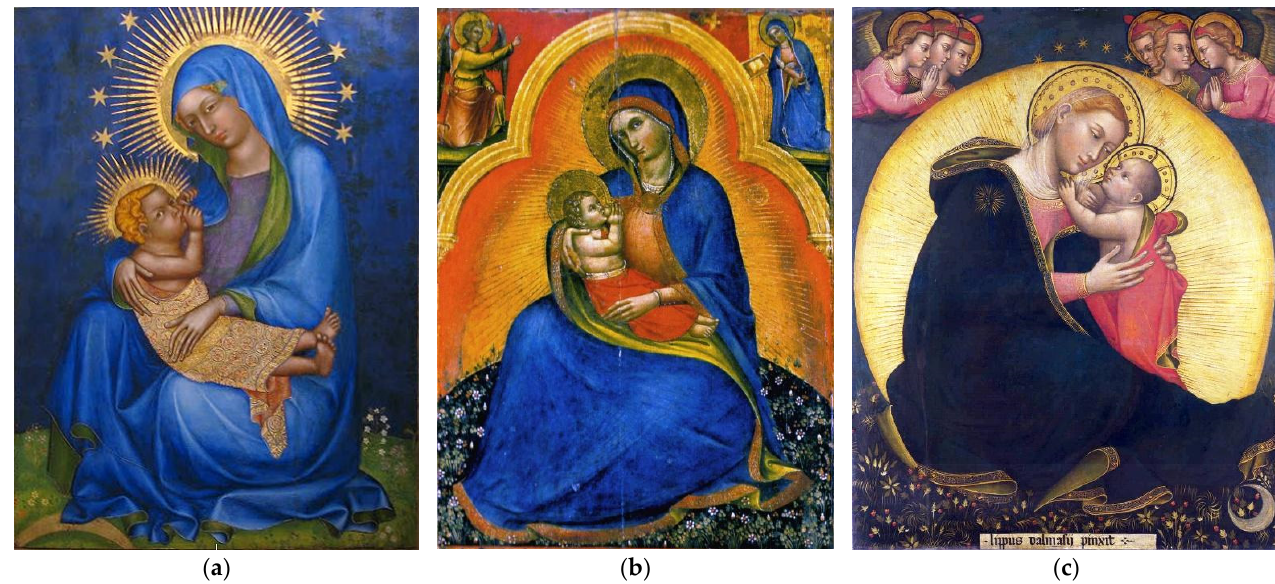
Figure 6. ( a ) Madonna of Vyšehrad , Bohemian painter, c. 1360, Praga, National Gallery; ( b ) Madonna dell’Umiltà, santi e confratelli della Scuola di san Giovanni Evangelista , Giovanni da Bologna, c. 1370, Venice, Accademia di Belle Arti, 17; ( c ) Madonna of Humility , Lippo di Dalmasio, c. 1390, London, National Gallery, NG752.